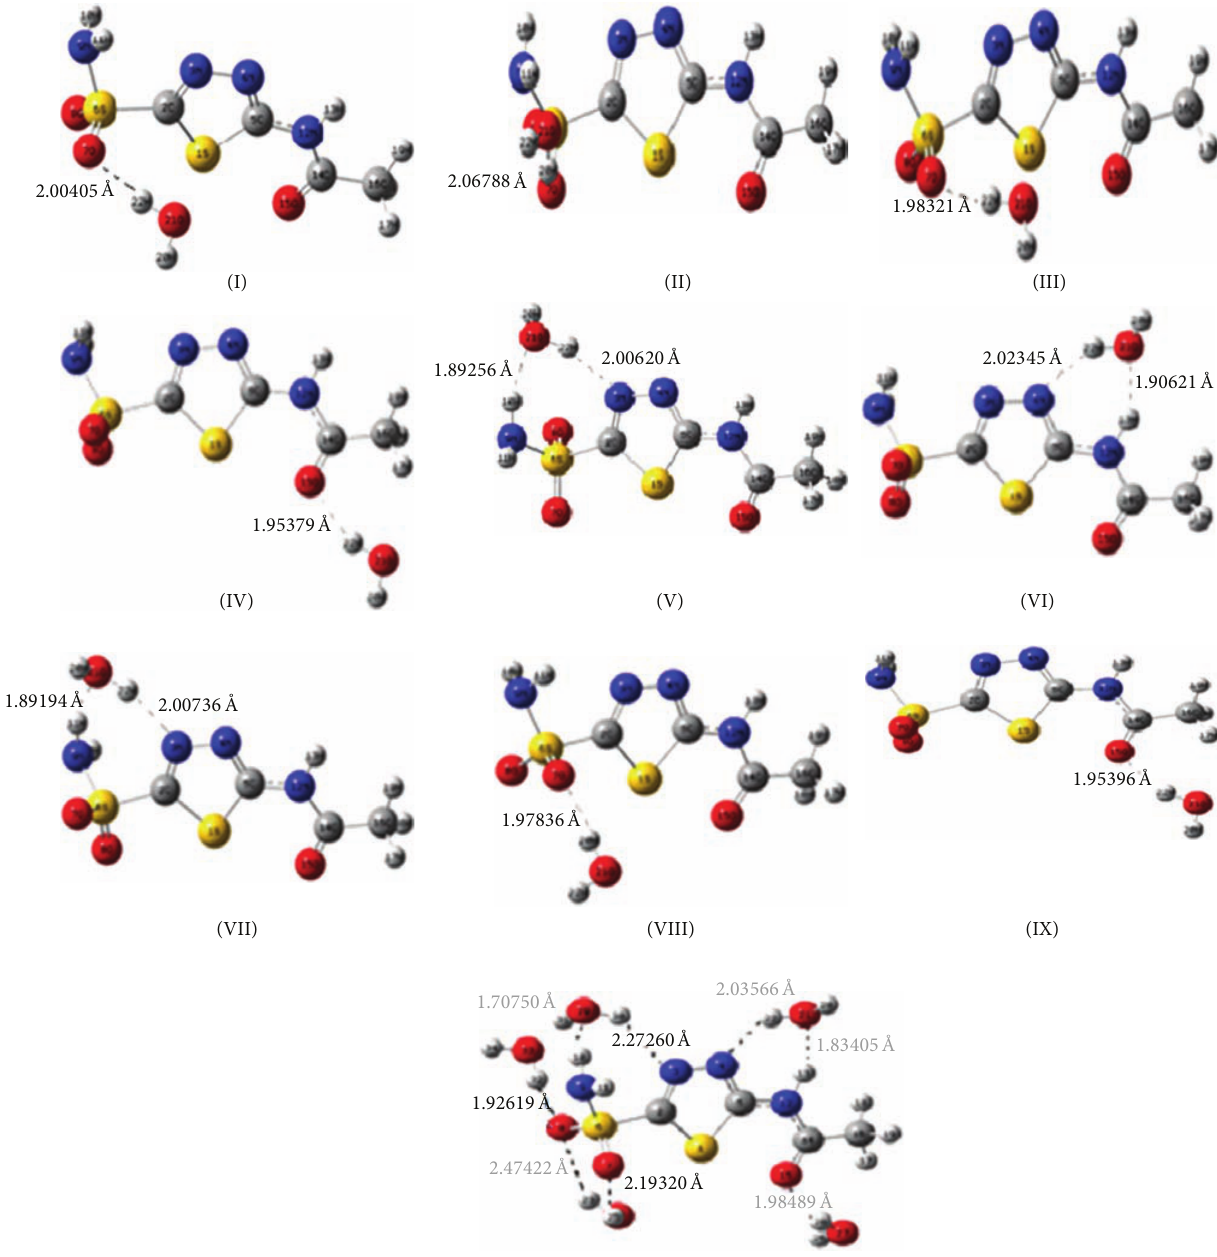
˚A˚A Figure 3: The energy minimized structures of ten low energy conformers (I–X) of H 2 O clusters of the acetazolamide (I–X), respectively. (BSSE) effect is rather significant on the structure and energy of dimer forms, so removing this effect is very important. Therefore, optimization of the dimer I was also carried out along with the counterpoise correction scheme proposed by Boys and Bernardi [29]. The BSSE uncorrected and corrected distances between two acetazolamide units {𝑅(5 C −22 C ) ( ˚A )} and binding energy (Δ𝐸) of acetazolamide dimer {Δ𝐸 = − 𝐸 } are given in Table 1(b). As seen in 2 ∗ 𝐸 monomer dimer Table 1(b), the energy of dimer I is found to be 17.39